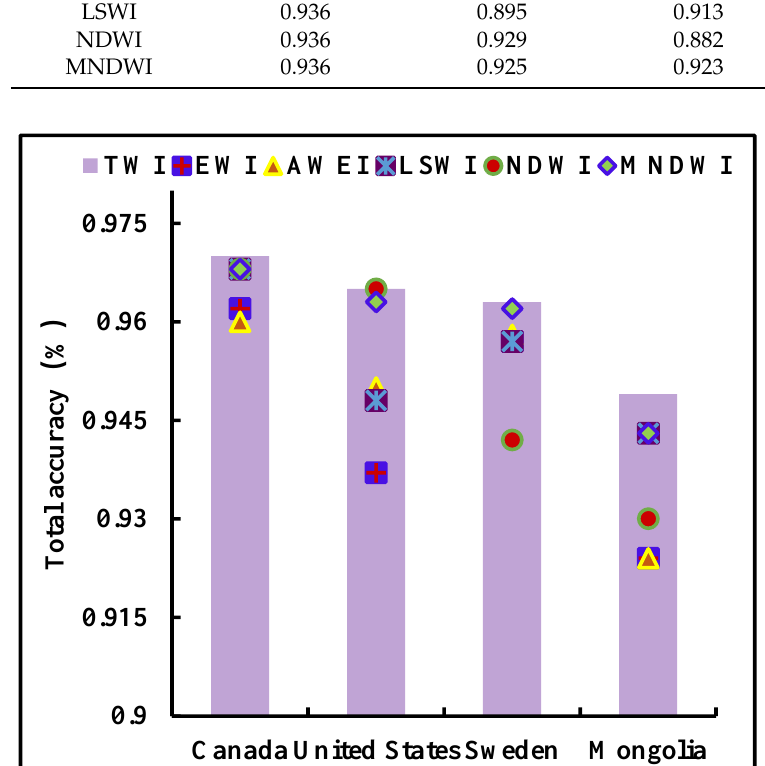
Figure 12. Overall precision of all water body indices at each of the four test sites.